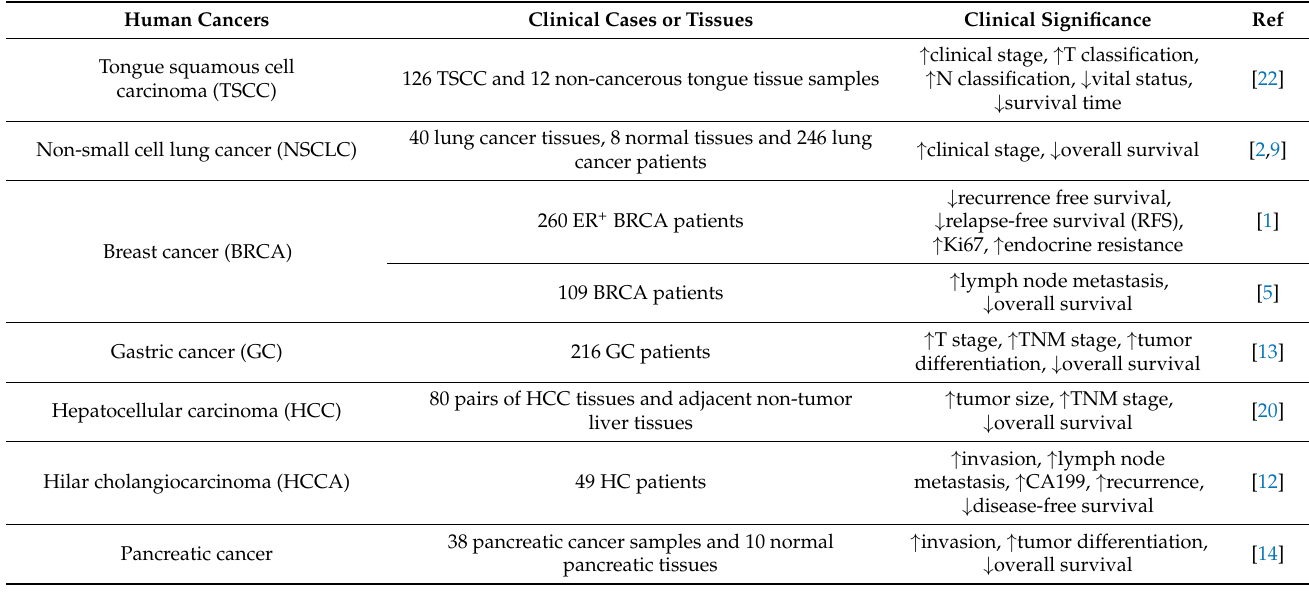
Table 2. Clinical significance of PRR11 in